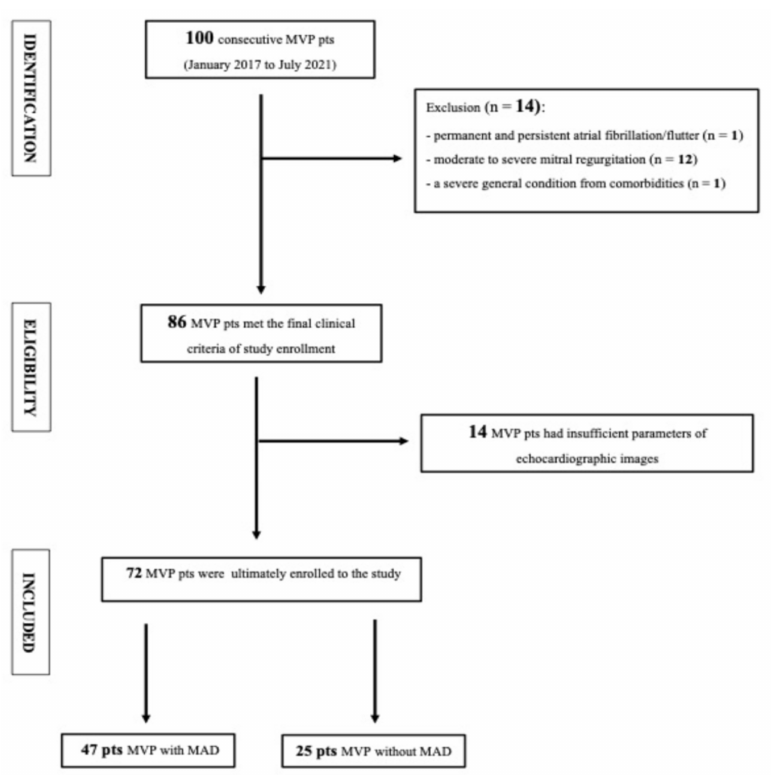
Figure 4. Flow chart of screened, included and excluded MVP